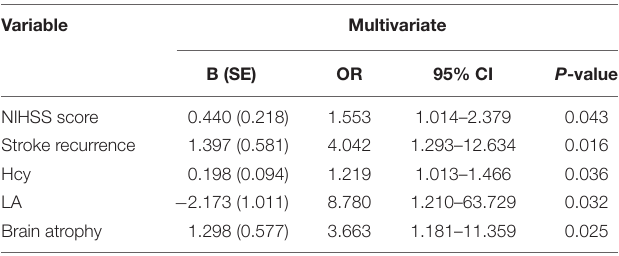
TABLE 2 | Multivariate logistic regression analysis of risk factor for PSCI after adjustment for